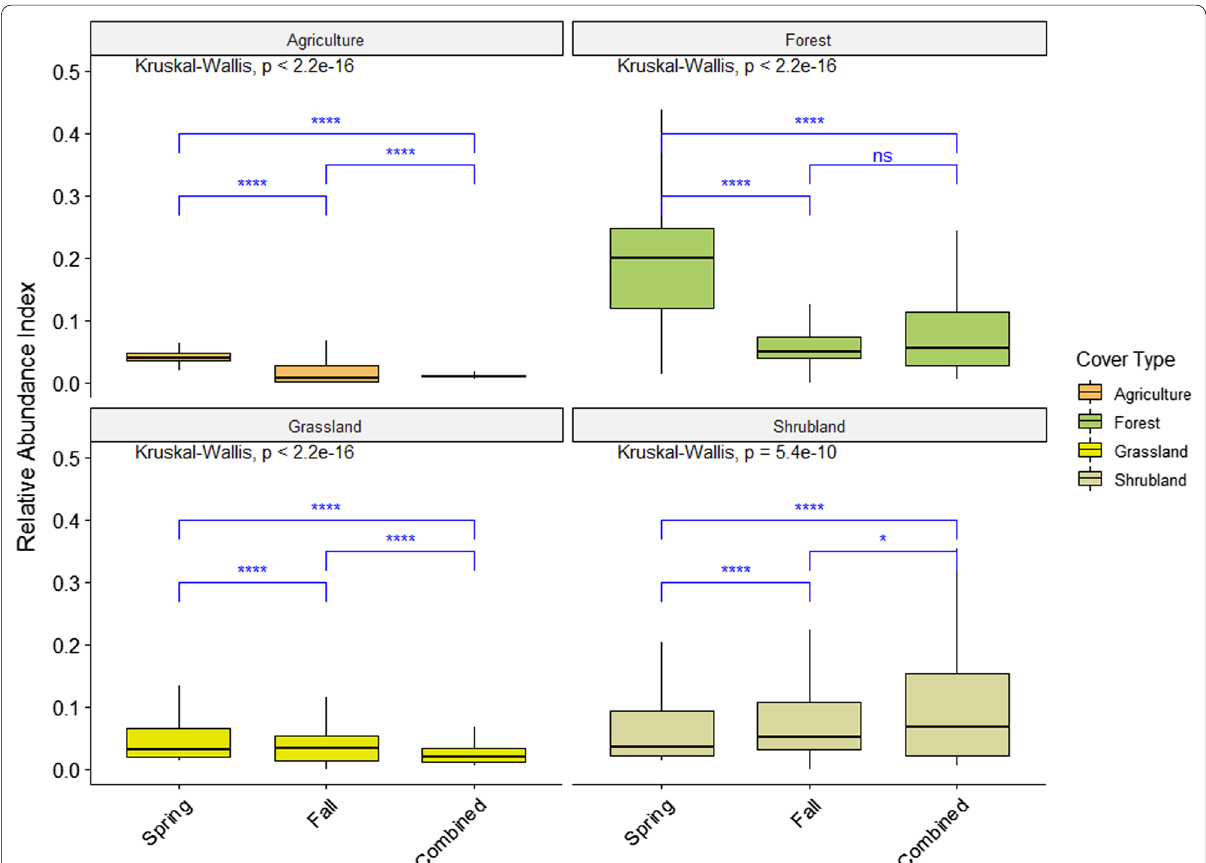
Fig. 4 Relative abundance estimates of wild pigs from model outputs (spring, fall, and combined) across landcover types. Blue brackets represent the comparisons being made using the Kruskal–Wallis test. Asterisks imply significance and NS means no significant difference ( p >